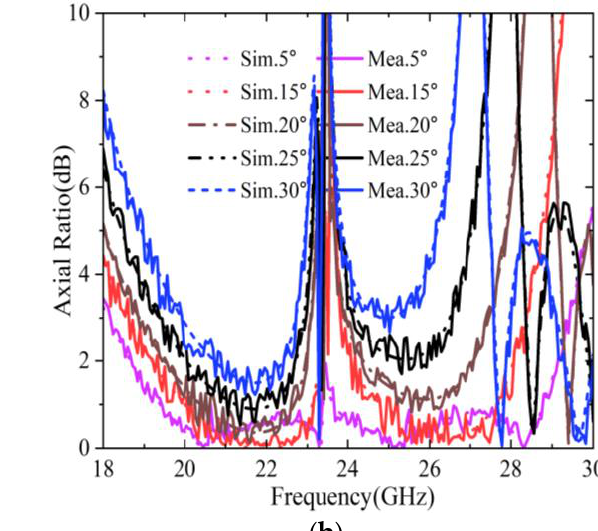
Table 1. Performance comparison of polarization converters in the literature .